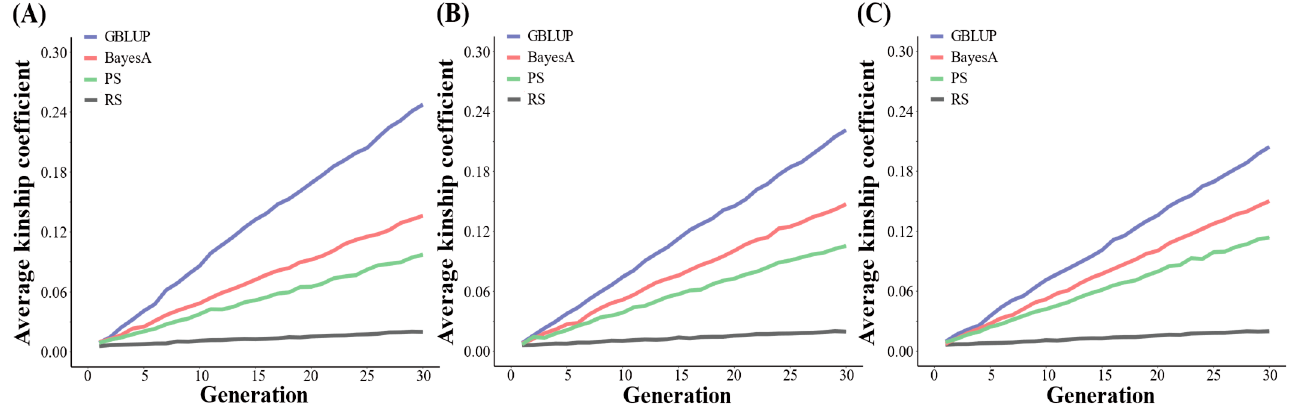
Figure 5. Average kinship coefficients of 4 strategies with low, medium, and high heritability traits using 54 K SNPs. ( A ) Average kinship coefficients for trait heritability of 0.1. ( B ) Average kinship coefficients for trait heritability of 0.3. ( C ) Average kinship coefficients for trait heritability of 0.5.